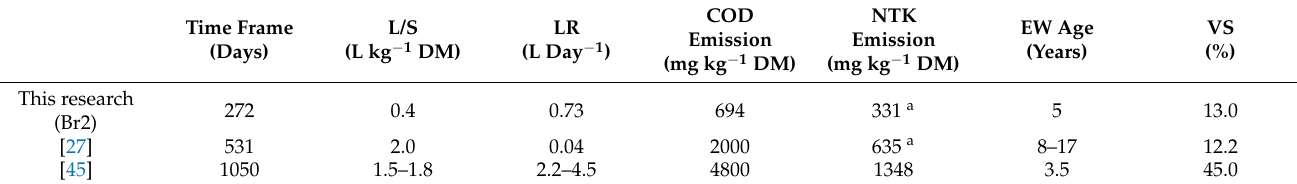
Table 3. Leachate emission potential in Br2 and comparison with reference